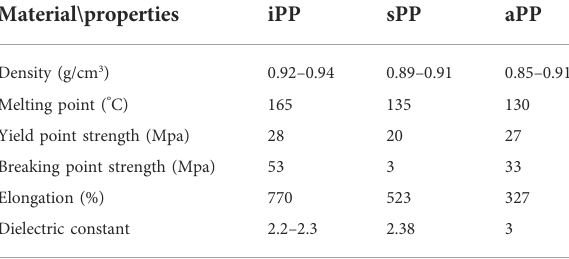
TABLE 1 Properties of iPP, sPP, and aPP [1 – 7]